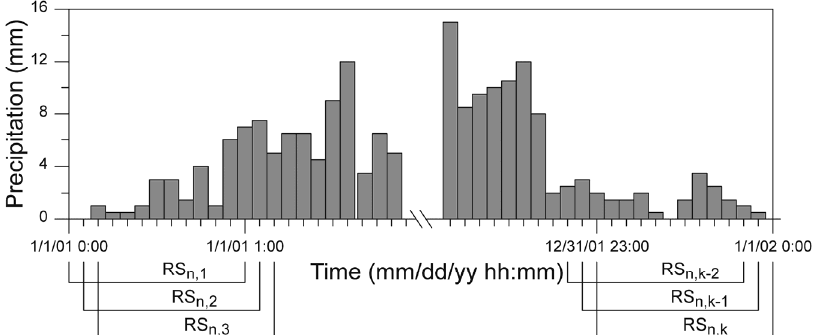
Figure 2. Selection of annual maximum rainfall based on the sliding